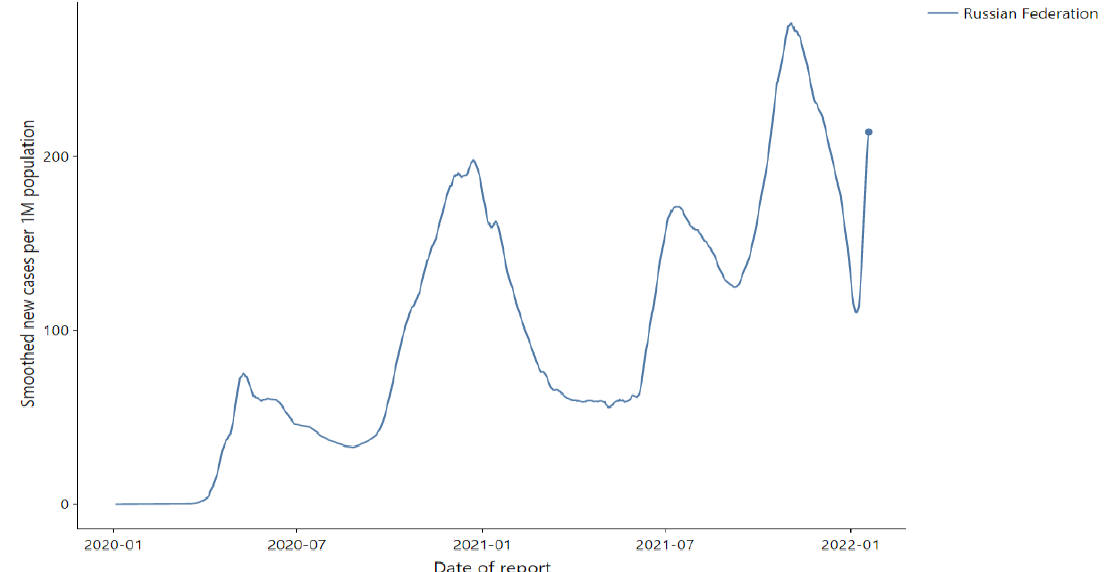
Figure 1. Spreading of the COVID-19 pandemic in Russia. (https://worldhealthorg.shinyapps.io/covid/, accessed on 30 January 2022).